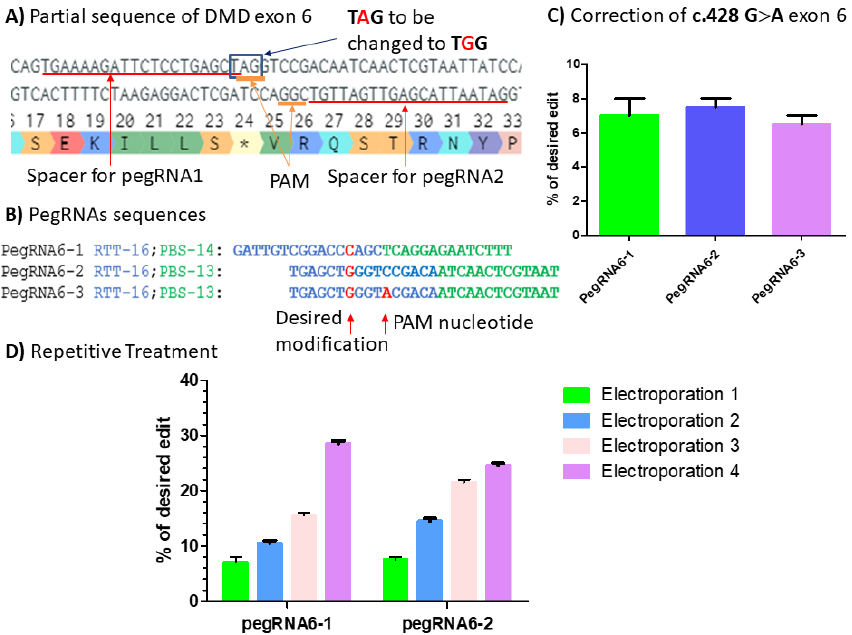
Figure 9. ( A ) Partial sequence of DMD exon 6 carrying c.428 G>A point mutation (*). The red lines indicate the spacer sequences for pegRNAs 1, 2 and 3 preceded by the PAM sequences AGG in the upper strand and CGG in the bottom strand. The blue square indicates the TAG codon to be changed to TGG codon, which is the tryptophan (W) amino acid. ( B ) PegRNA sequences with intended modifications highlighted in red: the C nucleotide to be introduced by pegRNAs6-1 and the G nucleotide to be introduced by pegRNA6-2 and pegRNA6-3. The A nucleotide is introduced by pegRNA6-3 for the simultaneous modification of the PAM sequence. ( C ) Results from Sanger sequencing for the three pegRNAs. ( D ) Sanger sequencing results for pegRNA6-1 and 2 for four repetitive treatments. The experiments were carried out in independent triplicates ( n = 3).